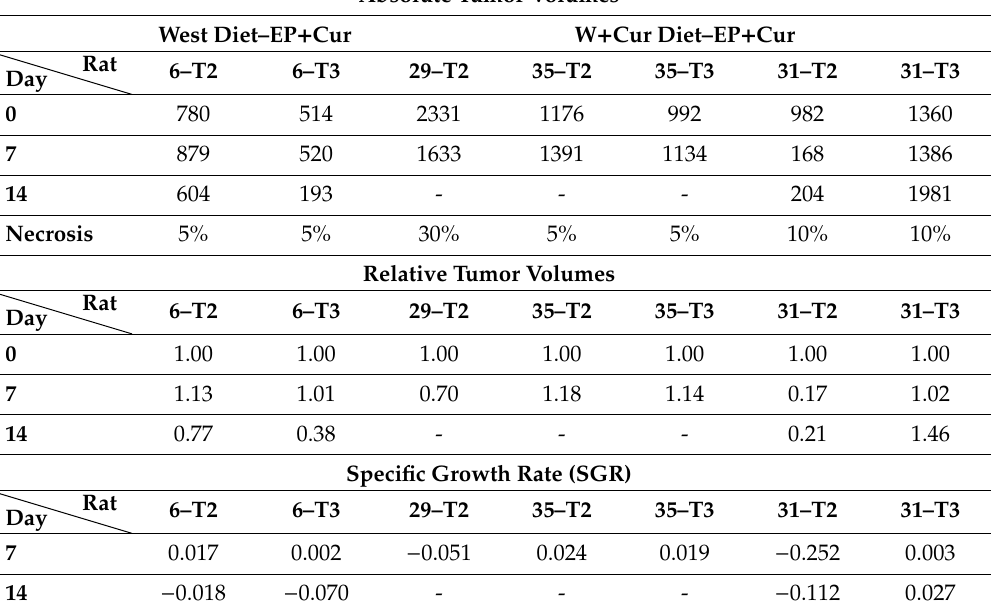
Table 4. Quantitative characterization of growth of second (T2) and third (T3) tumors only, after treatment with EP + Cur for both West and W + Cur diet. The relative tumor volumes and SGR were calculated for days 7 and 14 after treatment, compared to the tumor volume before start of the treatment (at day